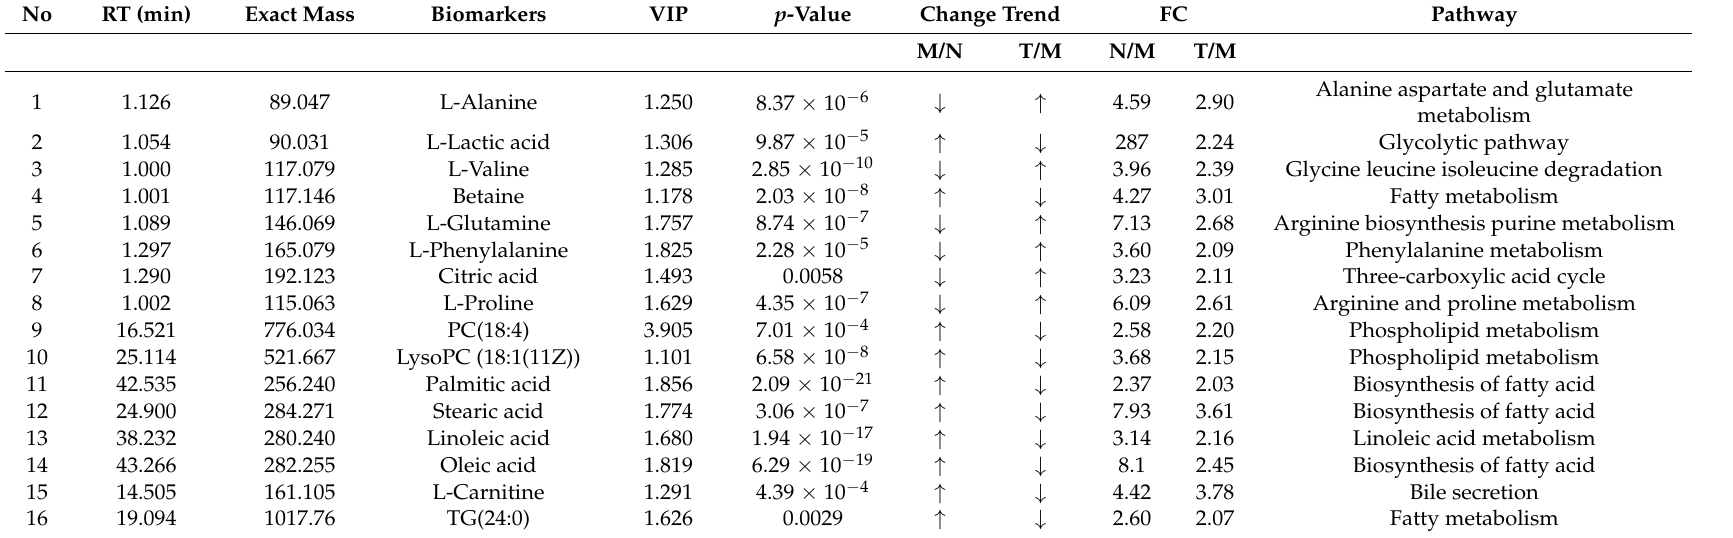
Table 1. Potential biomarkers identified in the samples and corresponding metabolic